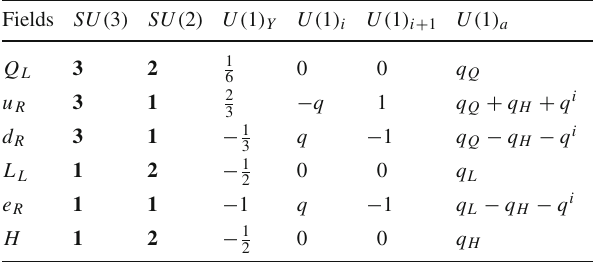
Table 2 SM charges that produce an ALP-spin coupling (the first columns indicate the gauge charges of the fields whereas the last one gives the PQ charges induced by (4.9), as functions of q Q , q H and q L which are